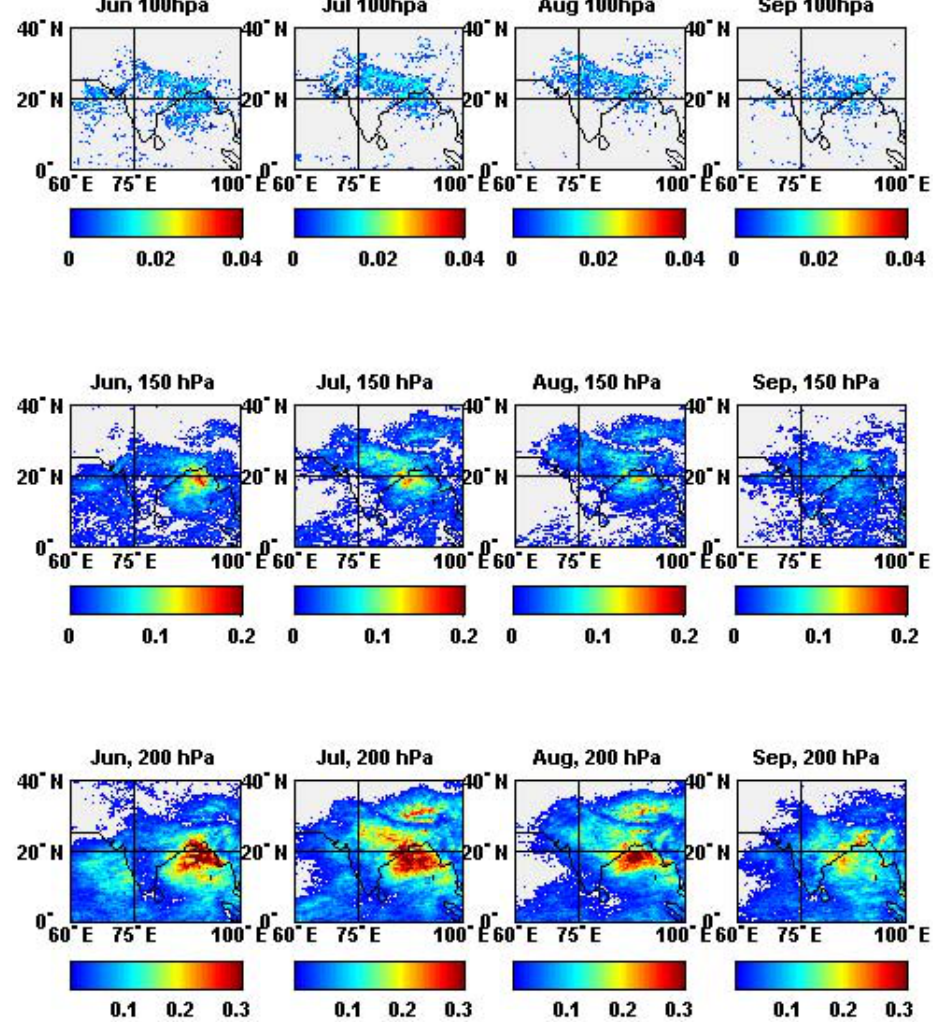
Fig. 3. Cloud fraction from AVHRR at 100hPa (top row), 150hPa (middle row) and at 200hPa (bottom row). The spatial resolution is 0.1 × 0.1 degrees. Data shown is climatological mean of the period 2003–2008; temperature data from AIRS is used to compute cloud fraction from AVHRR brightness